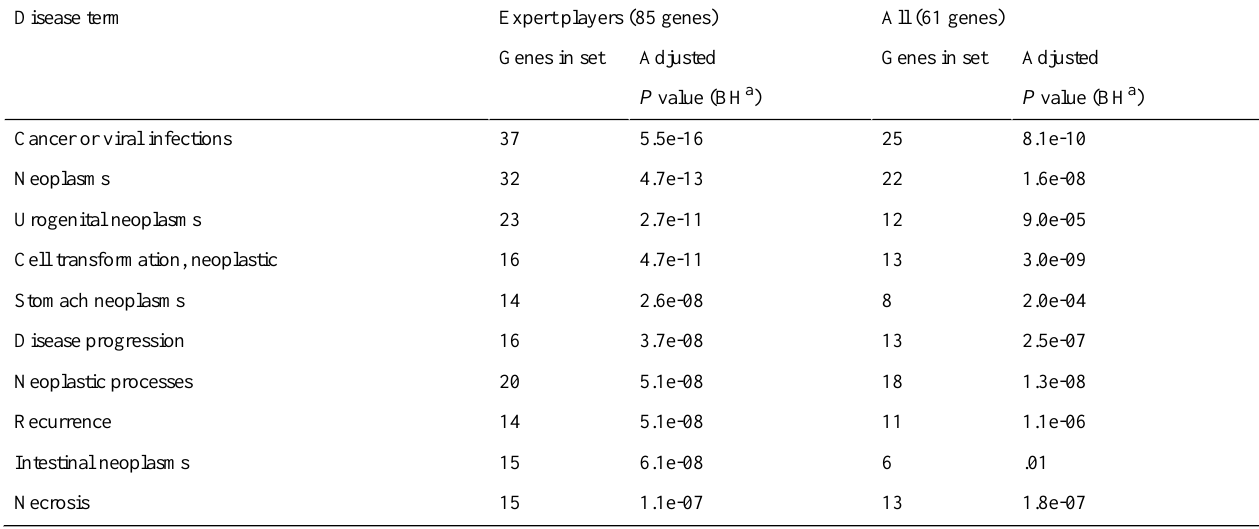
Table 2. The top ten disease terms for the “expert” gene set based on WebGestalt analysis. All reported disease terms had adjusted P values using the Benjamini & Hochberg correction for multiple testing <.001. All of these terms were also significantly enriched in the “all” gene set with P <.001 except “Intestinal neoplasms“ which had a corrected P value of .01 in that